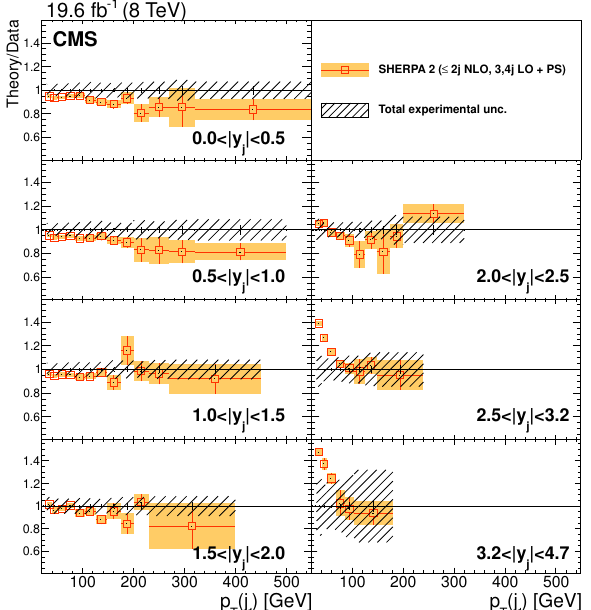
Figure 30 . Ratio to the measurement of the di(cid:11)erential cross section d 2 (cid:27)= d p T (j with MadGraph 5 + pythia 6, with up to four jets at LO. The total experimental uncertainty is shown as a band around 1. Uncertainties in the predictions are shown on the ratio points and include the statistical uncertainty only.